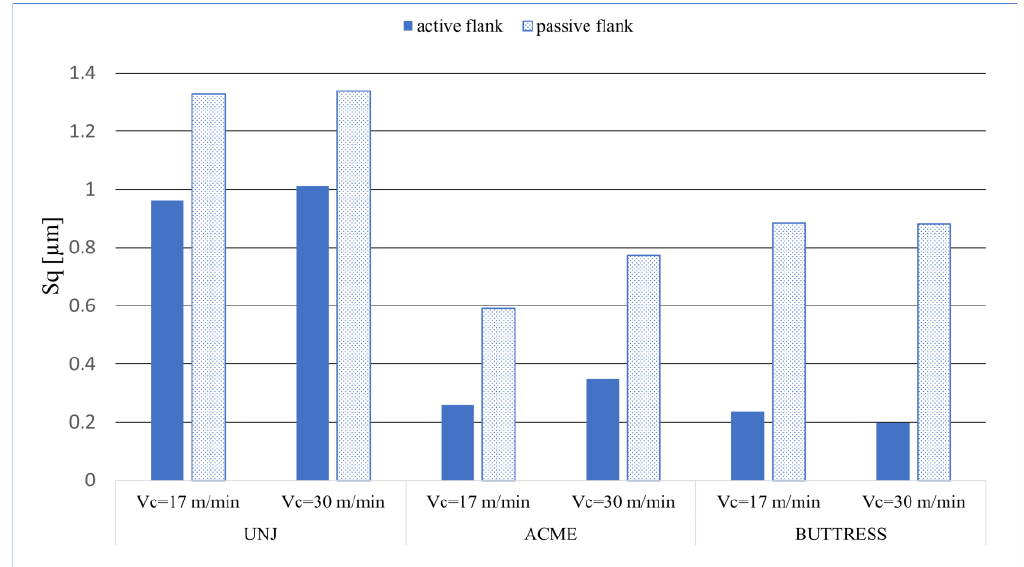
Figure 4. Sq values for the measured surfaces.